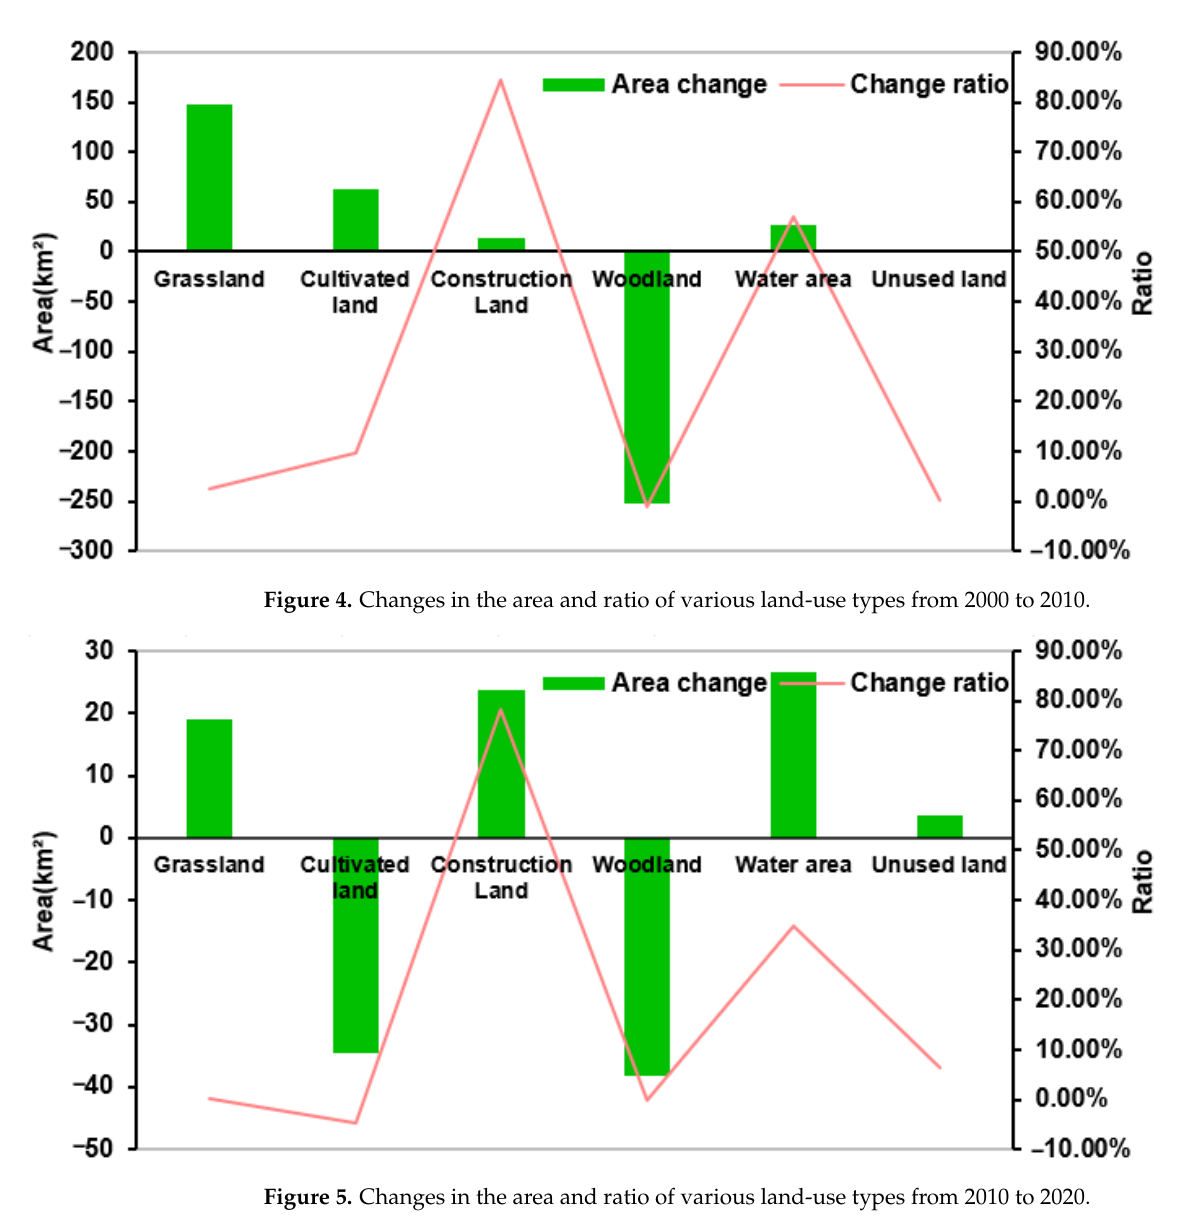
Figure 5. Changes in the area and ratio of various land-use types from 2010 to 2020.